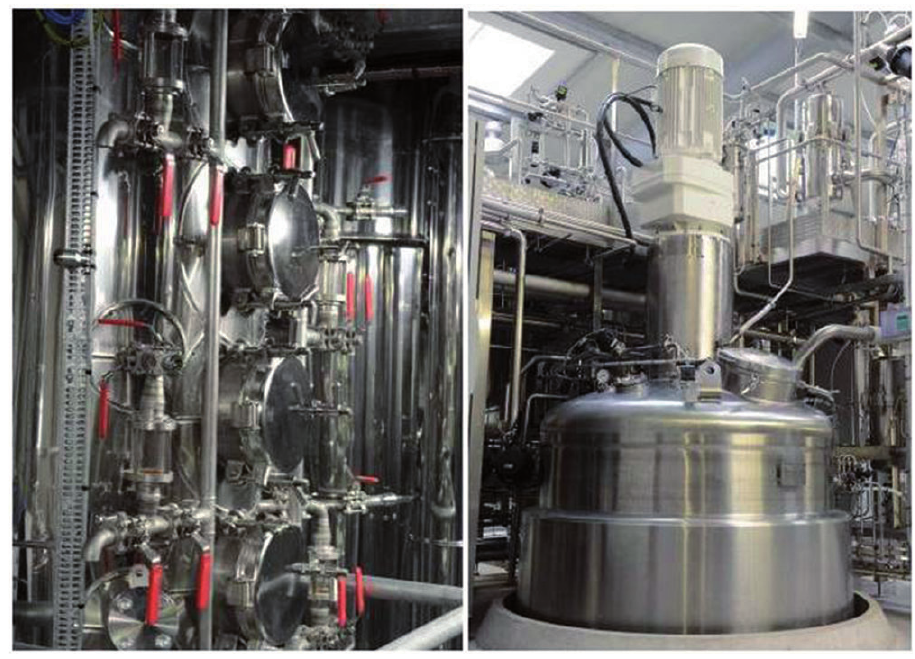
Figure 2 The Futurol project (Pomacle-Bazancourt, France): ethanol distillation tower (left side) and enzyme production (right